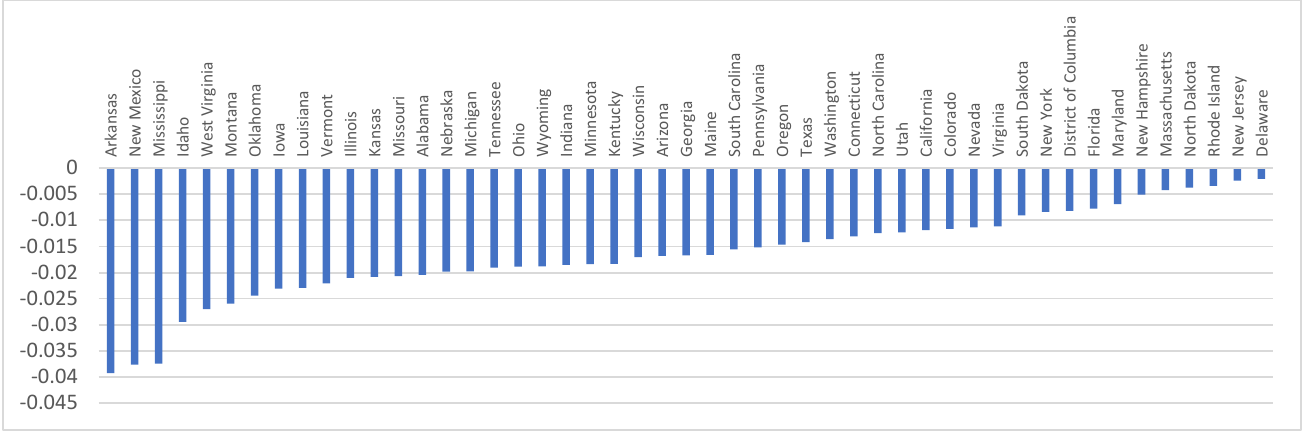
Figure 4. Elasticity GDP — Stringency Index.